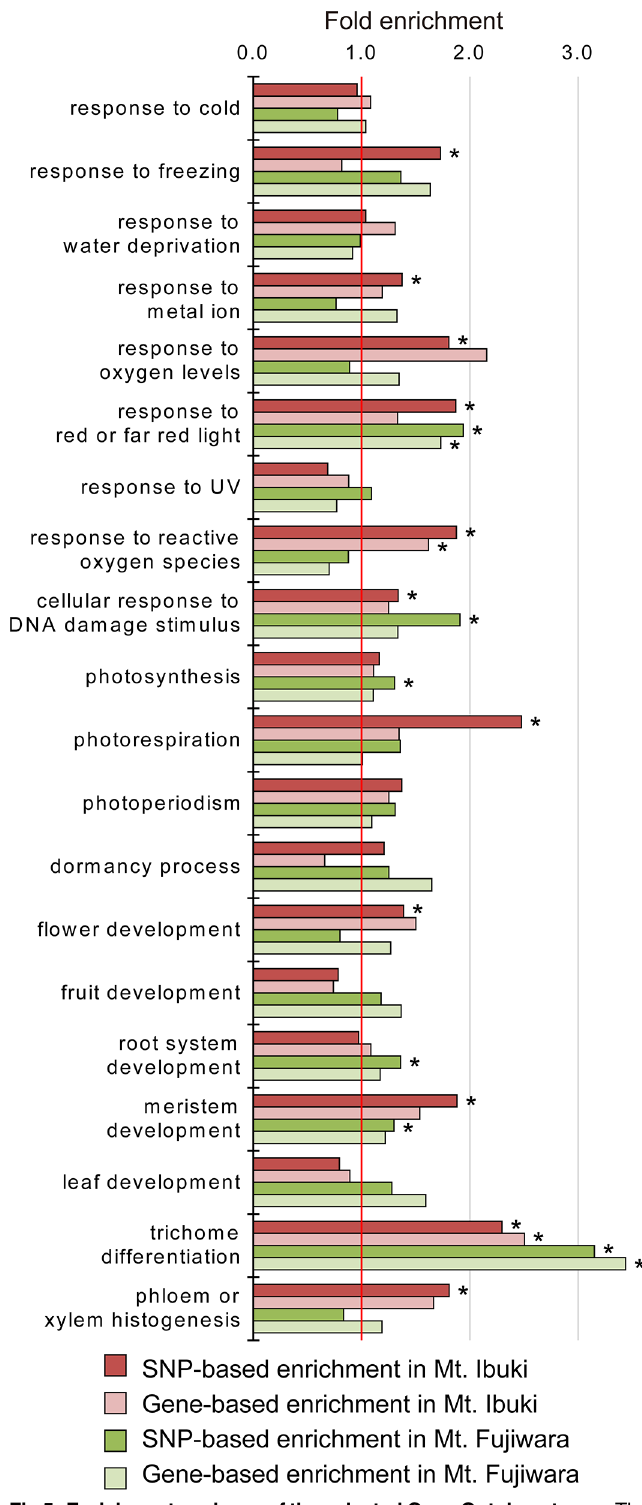
Fig 5. Enrichment analyses of the selected Gene Ontology terms. The histograms show the fold enrichment of a given GO term within each dataset for the two mountains. Vertical red line indicate the expected ratio of SNPs or genes associated with a specific GO term under the null hypothesis.